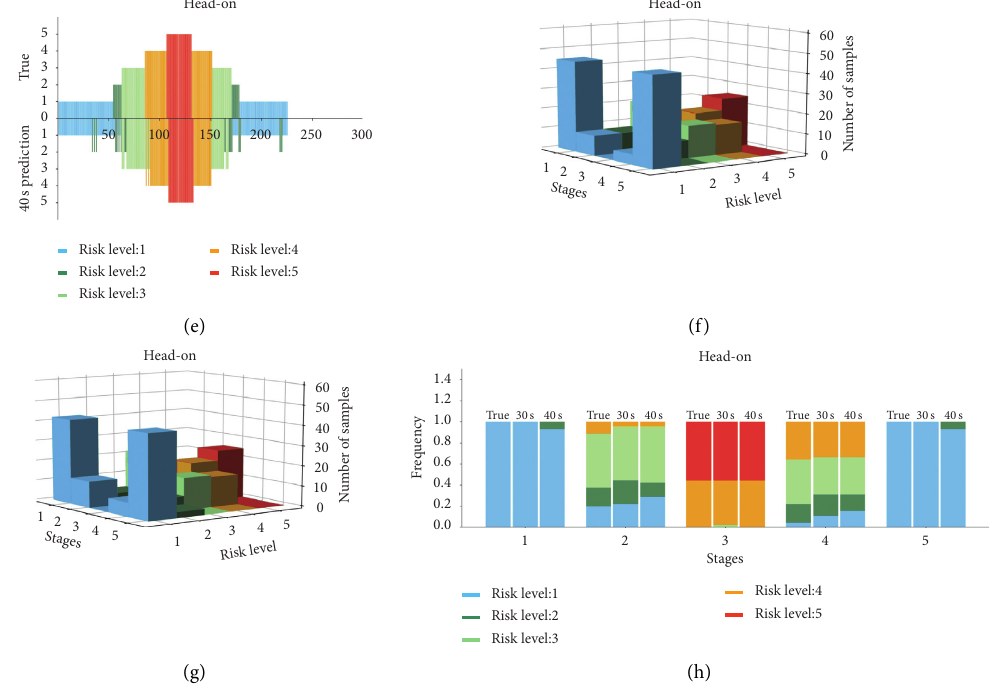
Figure 10: Head-on situation: (a) and (b) are the spatial distribution of risk level under various prediction horizons; (c) is the corresponding spatial distribution of realistic risk level. (d) and (e) show the risk level statistics of each window under two prediction horizons. (f) and (g) are the number of samples of each risk level in the five stages. (h) is the frequency of each risk level at various stages.